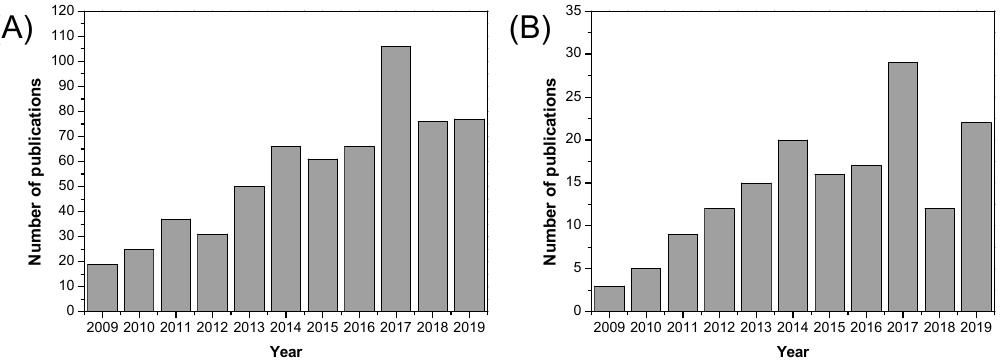
Figure 24. Number of publications in the period of 2009–2019 indexed in the Web of Science: ( A ) keywords: electrospinning AND fuel cell; and ( B ) keywords: electrospinning AND fuel cell AND proton exchange membrane. Source: www.webofknowledge.com.